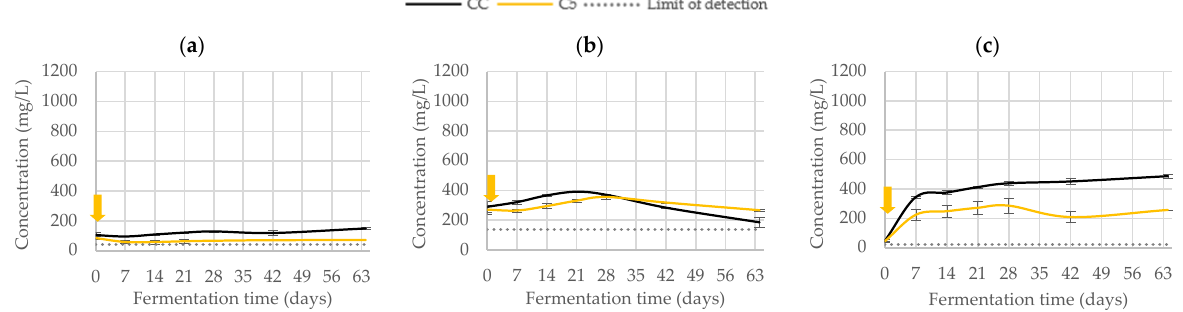
Figure 6. Evolution in phenolic profile, ( a ) oleuropein, ( b ) hydroxytyrosol, and ( c ) tyrosol, of table olive brine throughout fermentation under plan B. Arrows indicate the moment of inoculation with Lpb. pentosus i106 and the corresponding salt addition to all vessels.